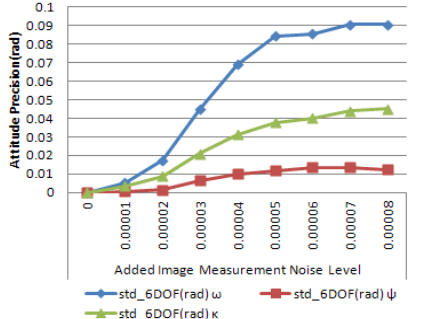
Figure 10. Variation of attitude precision at different image measurement noise